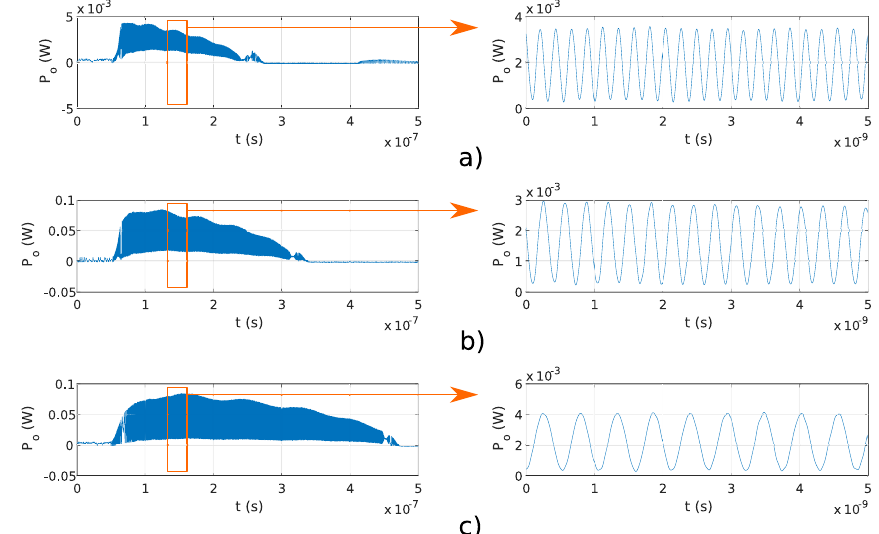
Figure 9. Pulses and fringes measured with the Michelson fiber interferometer using ∆ L = 0.16 m and